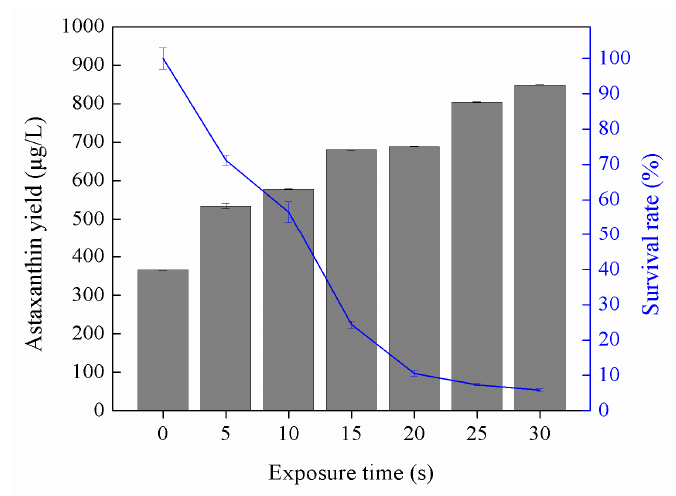
Figure 1. Effect of UV exposure time on the survival rate of wild-type R. toruloides . Data are mean ± SD of three replicates. Table 2. Biomass and astaxanthin production by UV-induced